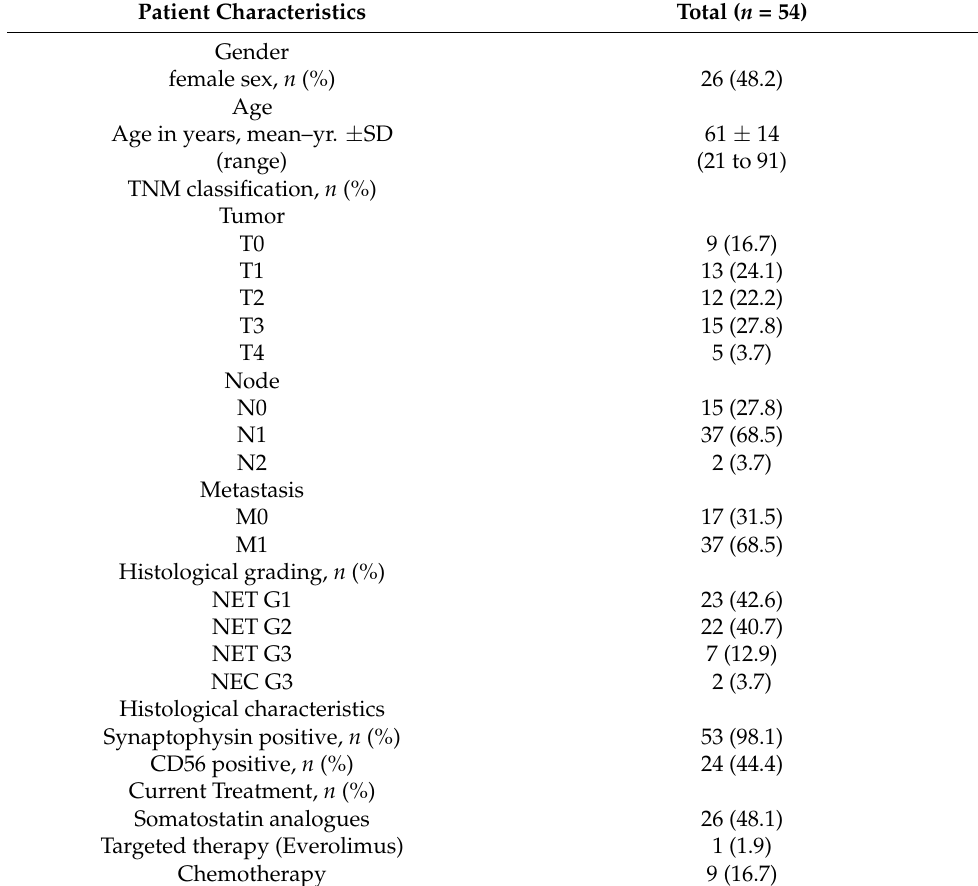
Table 1. Patient characteristics of the NEN screening cohort